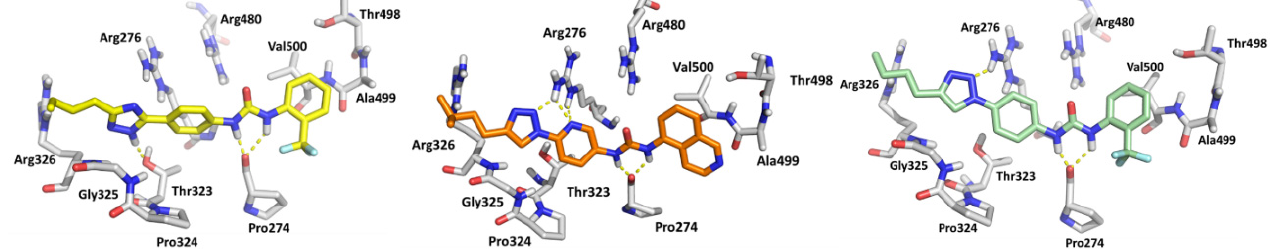
Figure 2. Predicted binding mode of compounds 4 (yellow), 10 (orange), and BA103 (light green) in the RNA-binding site. Hydrogen bond interactions are represented in yellow lines (Supplementary Information for other selected compounds in Figure S1).